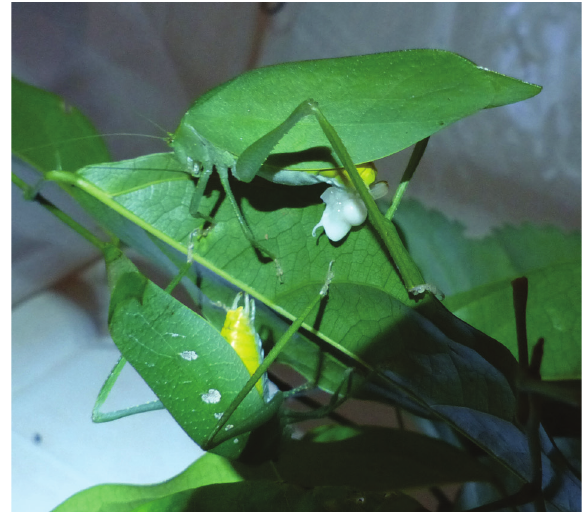
Figure 13. Pair of Gonatoxia maculata shortly after mating. Note the white spermatophore at the abdomen of the female.